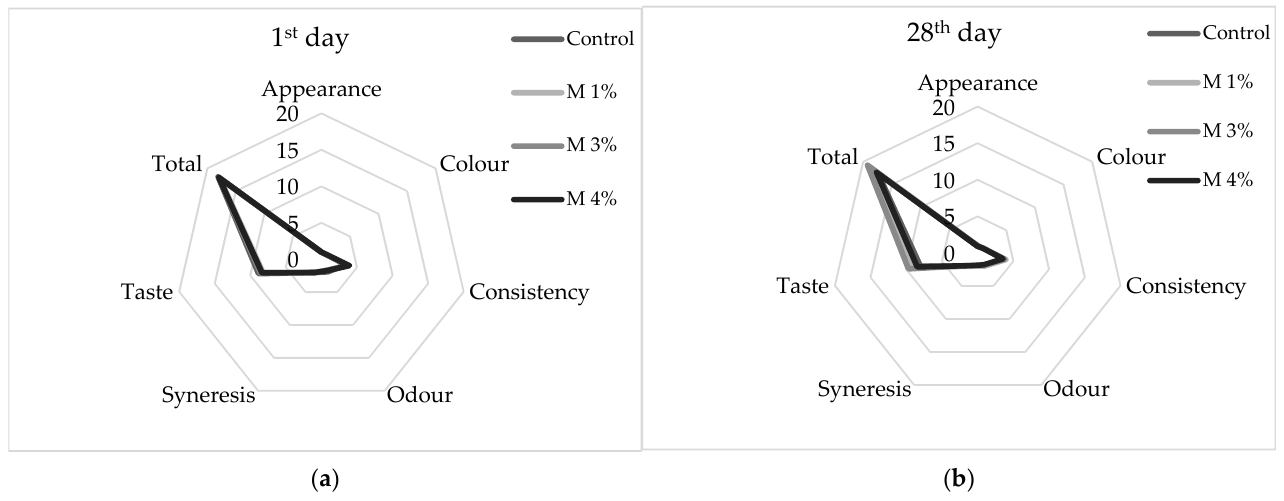
Figure 4. Total sensory scores of yoghurt samples without (Control) and with the addition of moringa extract (M 1%, M 3% and M 4%) at the 1st ( a ) and 28th ( b ) day of cold storage